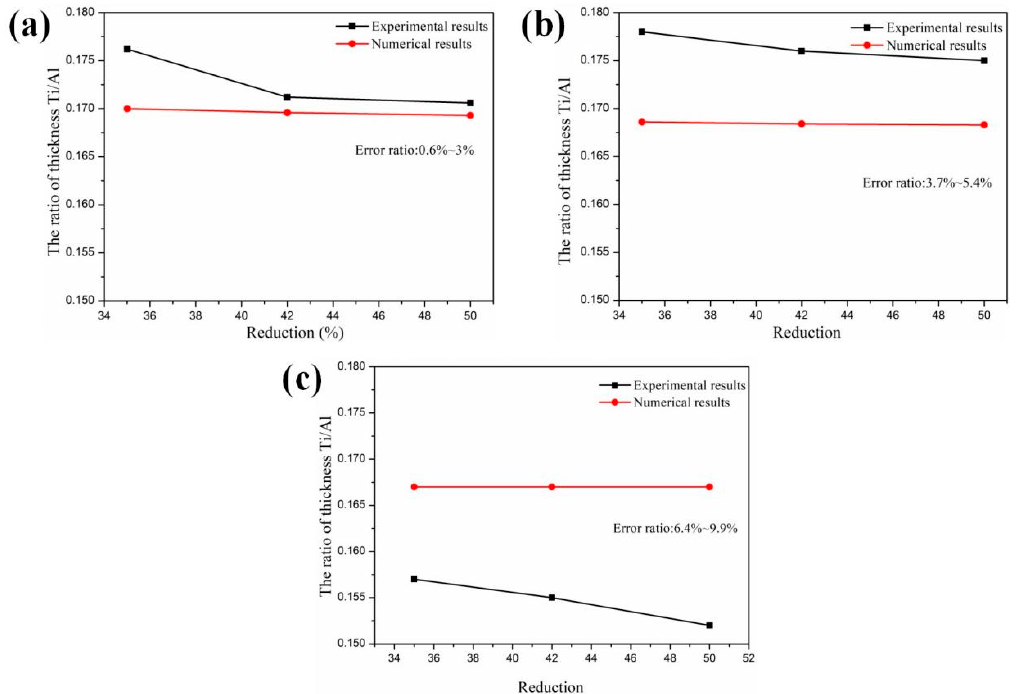
Figure 8. Ti/Al thickness ratio values measured using theoretical model and experiment under dif- ferent aluminum strengths. ( a ) S1, ( b ) S2, ( c )